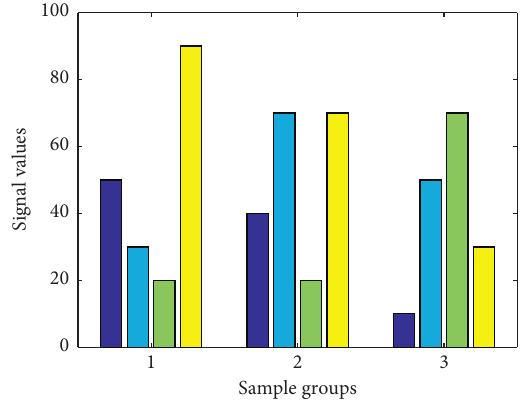
Figure 4: Histogram of the proportion of patients’ brain wave signals in music